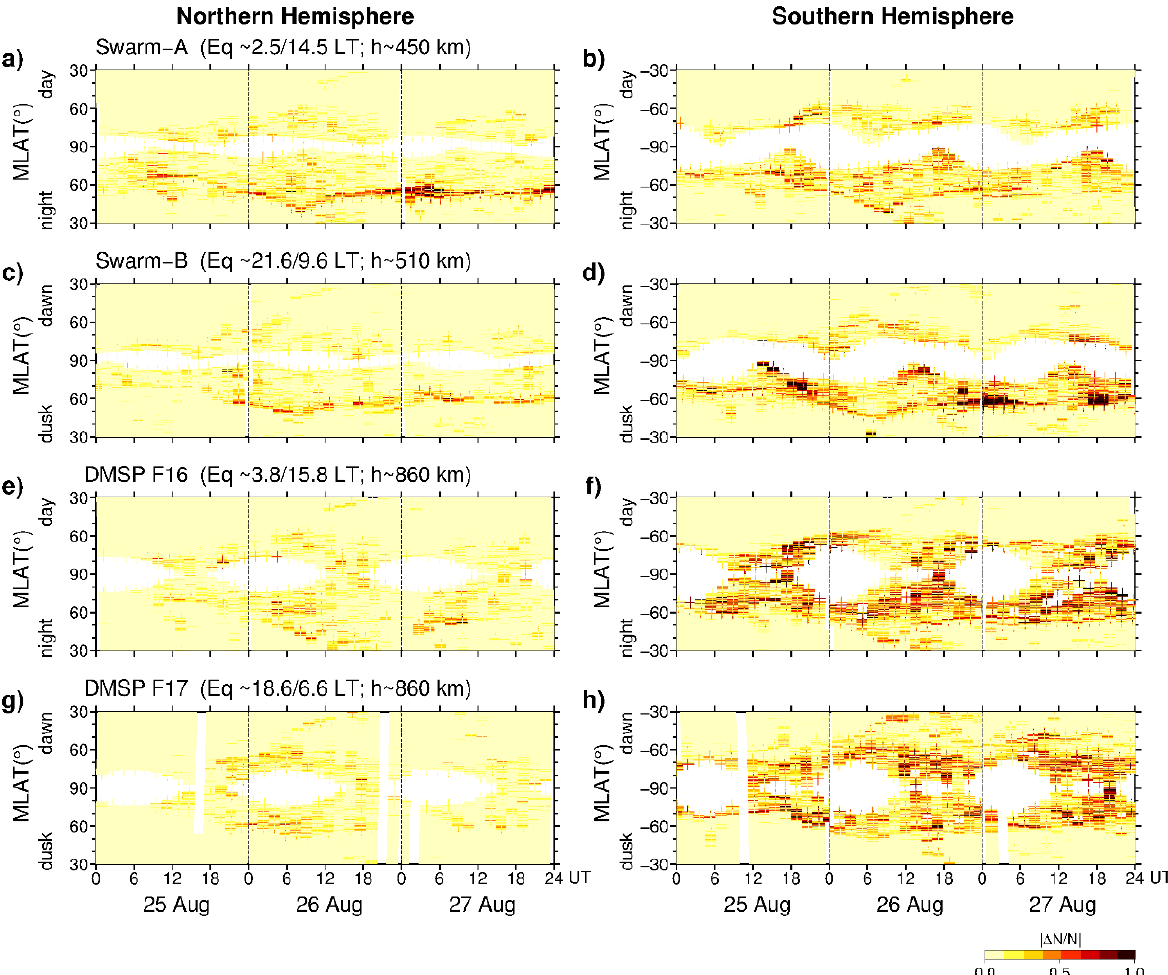
Figure 7. Satellite-based in situ density variations |∆N/N| plotted as a function of geomagnetic latitude (the y axis) and UT time (the x axis) during 25–27 August 2018 for the ( left ) Northern and ( right ) Southern Hemispheres for ( a,b ) Swarm-A, ( c , d ) Swarm-B, ( e,f ) DMSP F16, and ( g,h ) DMSP F17 satellites. Continuity leaps (white areas close to 90 ◦ N/S MLAT) appear due to satellite pass displacement from the magnetic poles.